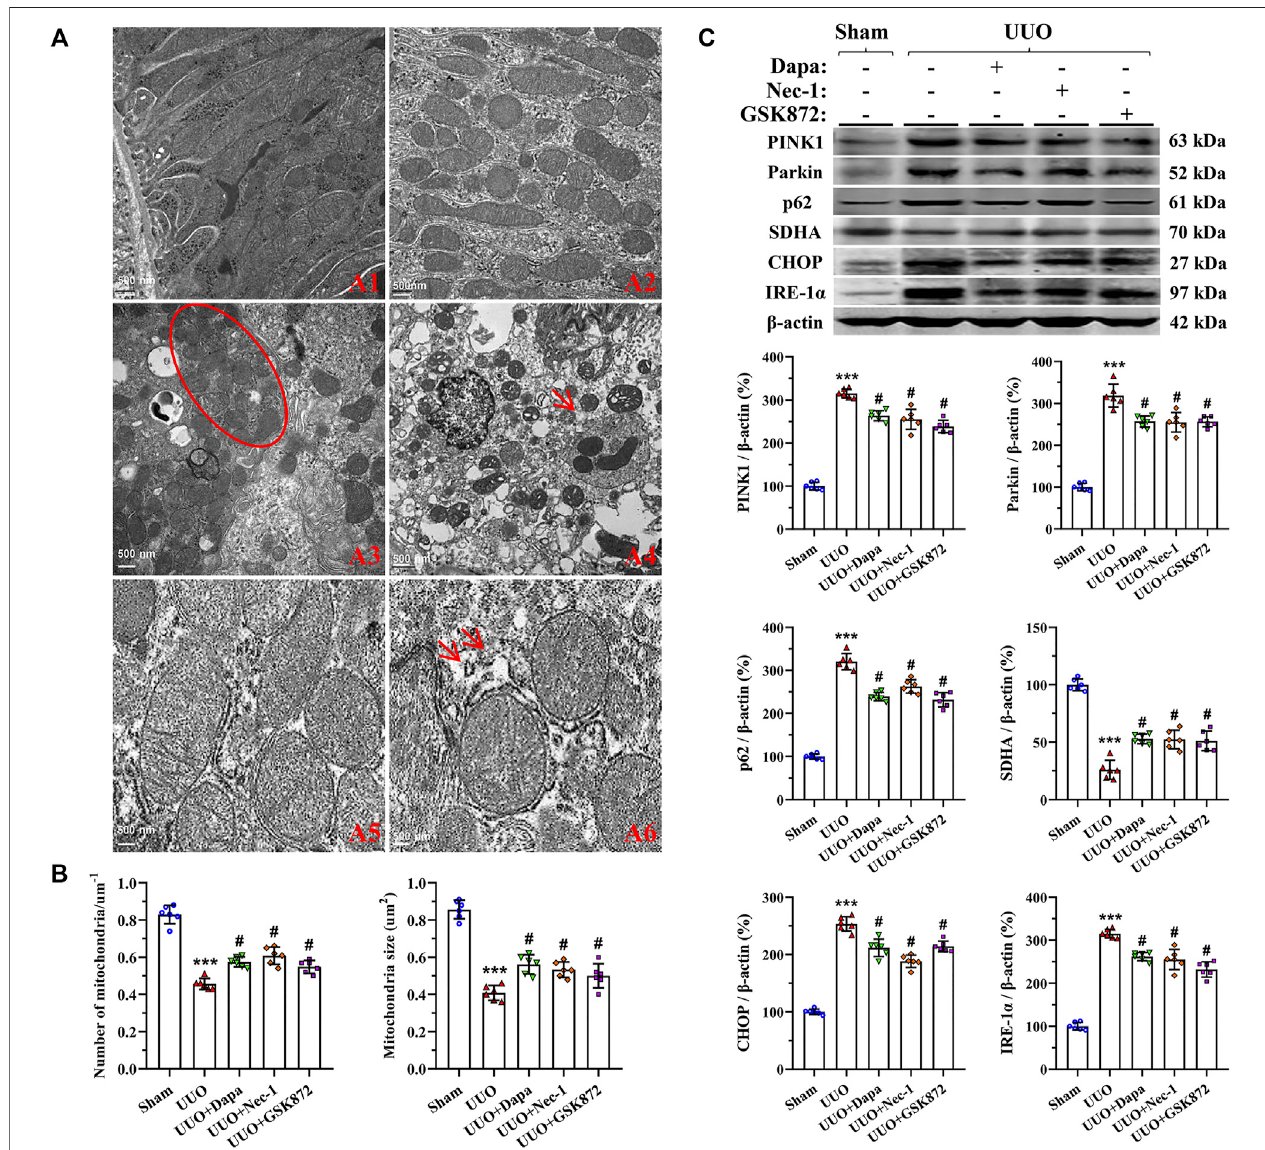
FIGURE5| RepresentativephotomicrographsoftransmissionelectronmicroscopyofmitochondrialandERmorphology (A) ,quantitativeanalysisofmitochondrial numberandsize (B) ,andimmunoblottinganalysisofmitochondria-andERstress-relatedproteins (C) .A1,normalmitochondria;A2,reducedmitochondrianumberand sizeandmitochondriafusion;A3,mitochondriadividedintotwoormoreorganelles(circle);A4,autophagyofmitochondria(mitophagy,arrow);A5,normalroughER;A6, degranulation of ribosomes and disconnected and dilated cisternae of rough ER (arrows). Data are presented as mean ± SEM ( n (cid:2) 6) and analyzed by one-way ANOVA. *** p < 0.01 vs sham; # p < 0.05 vs UUO.